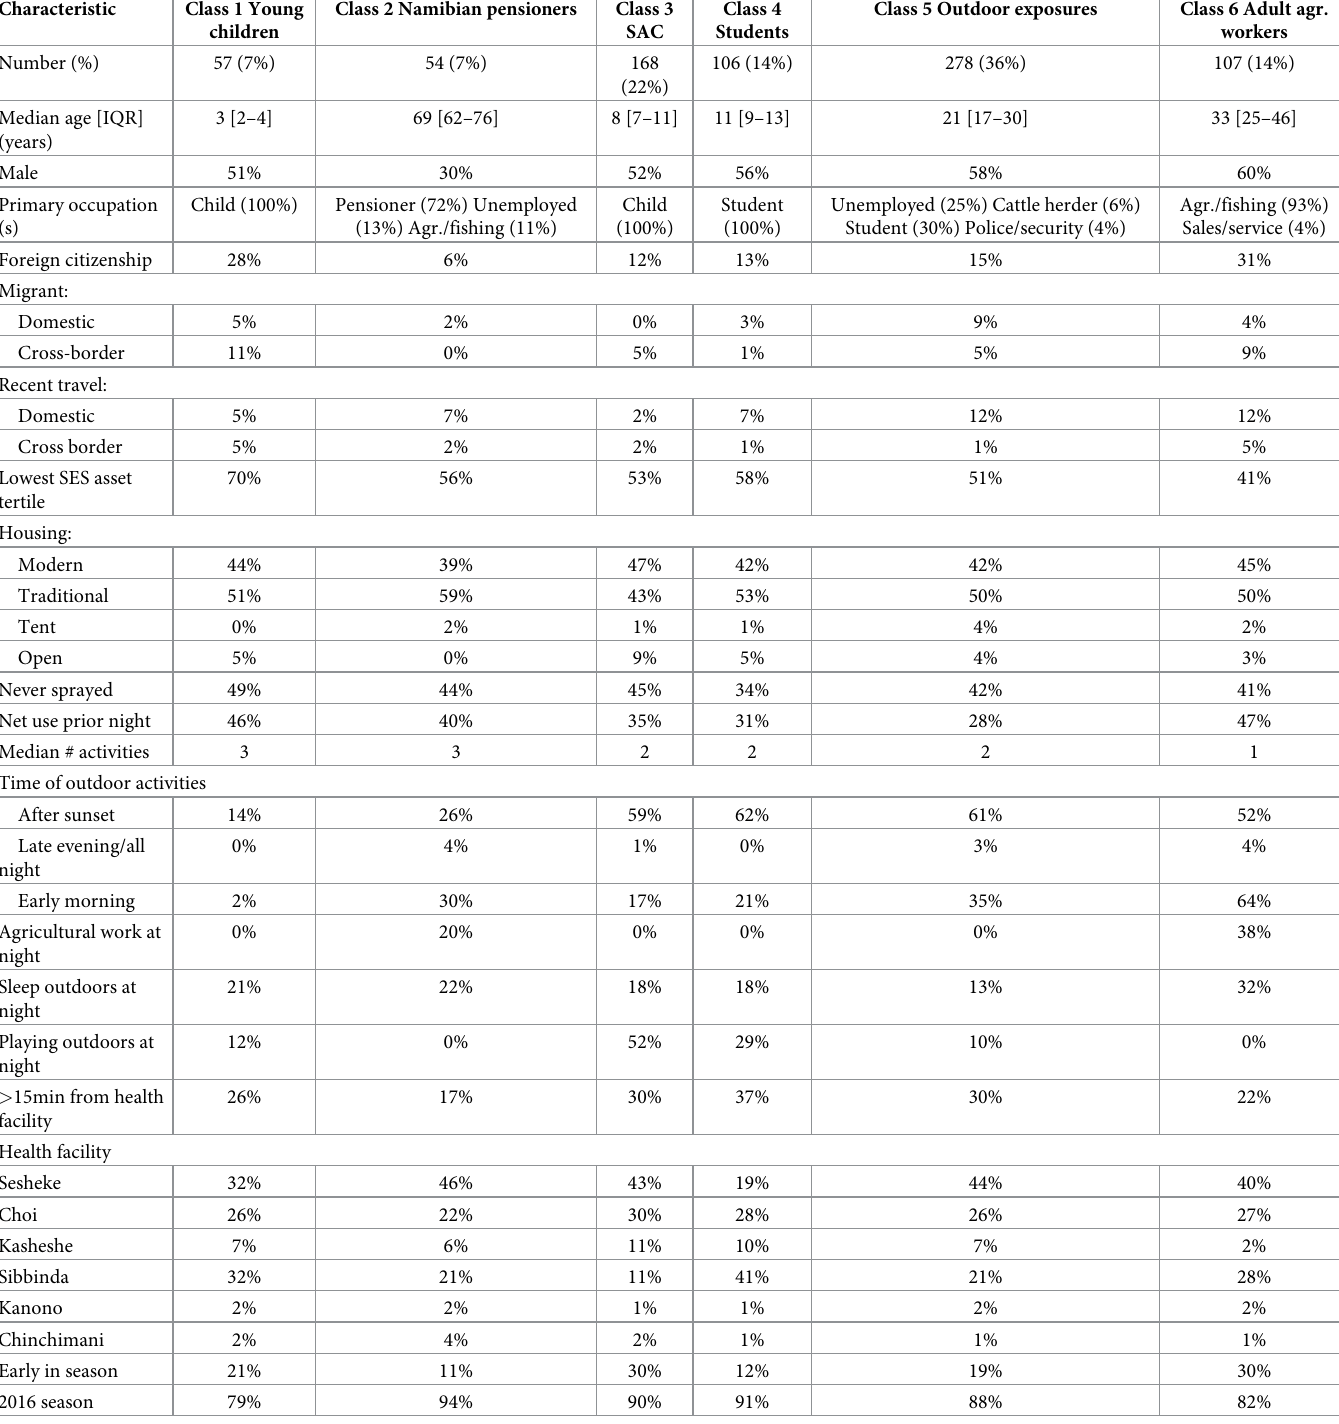
Table 3. Profiles of six high risk malaria clusters based on individual risk factors, including select class conditional probabilities (full in S3 Table) and key socio- demographic and behavioral indicators.